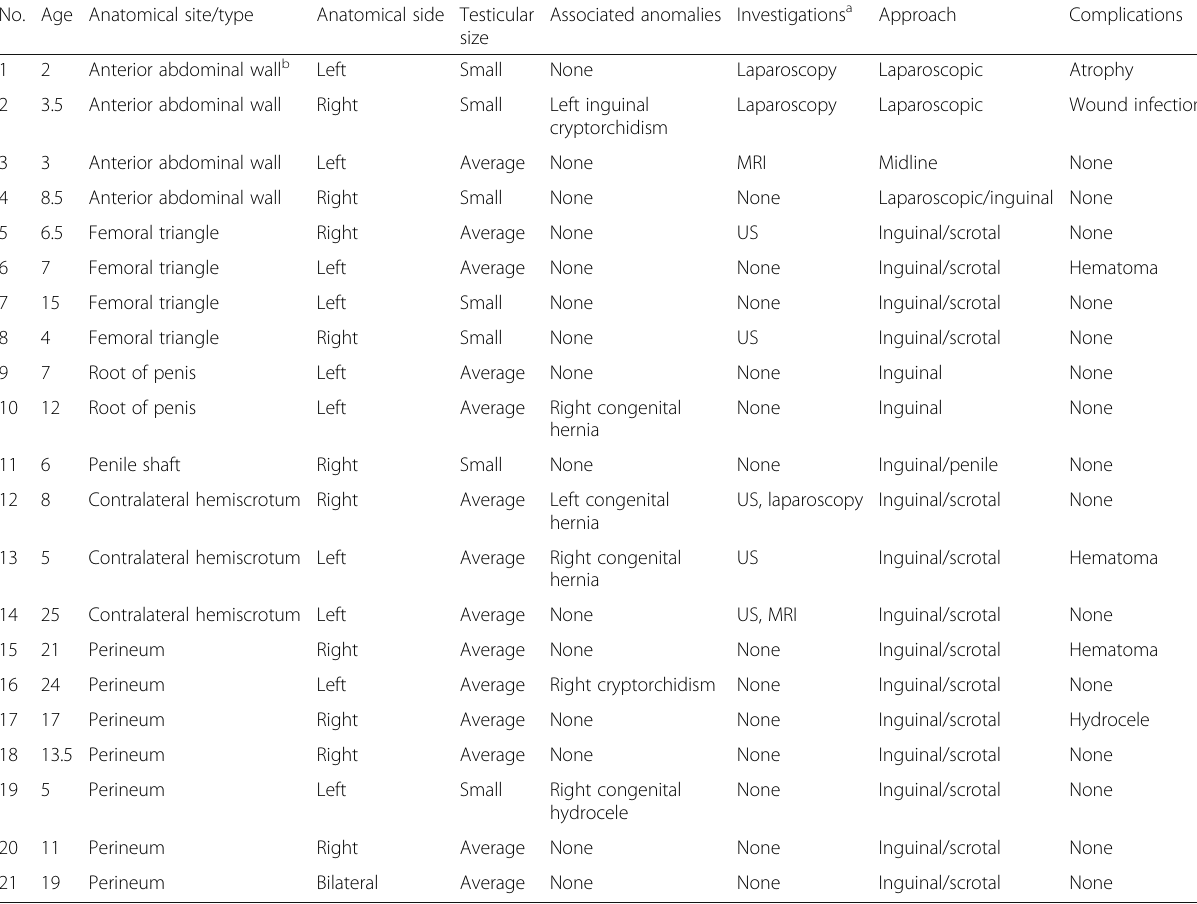
Abbreviations : MRI magnetic resonance imaging, NA not available data, US ultrasonography a Investigations here refer to the non-laboratory workups including imaging and laparoscopy. Imaging were requested before presentation to our center b Anterior abdominal wall locations were preperitoneal in 3 cases and interstitial in 1